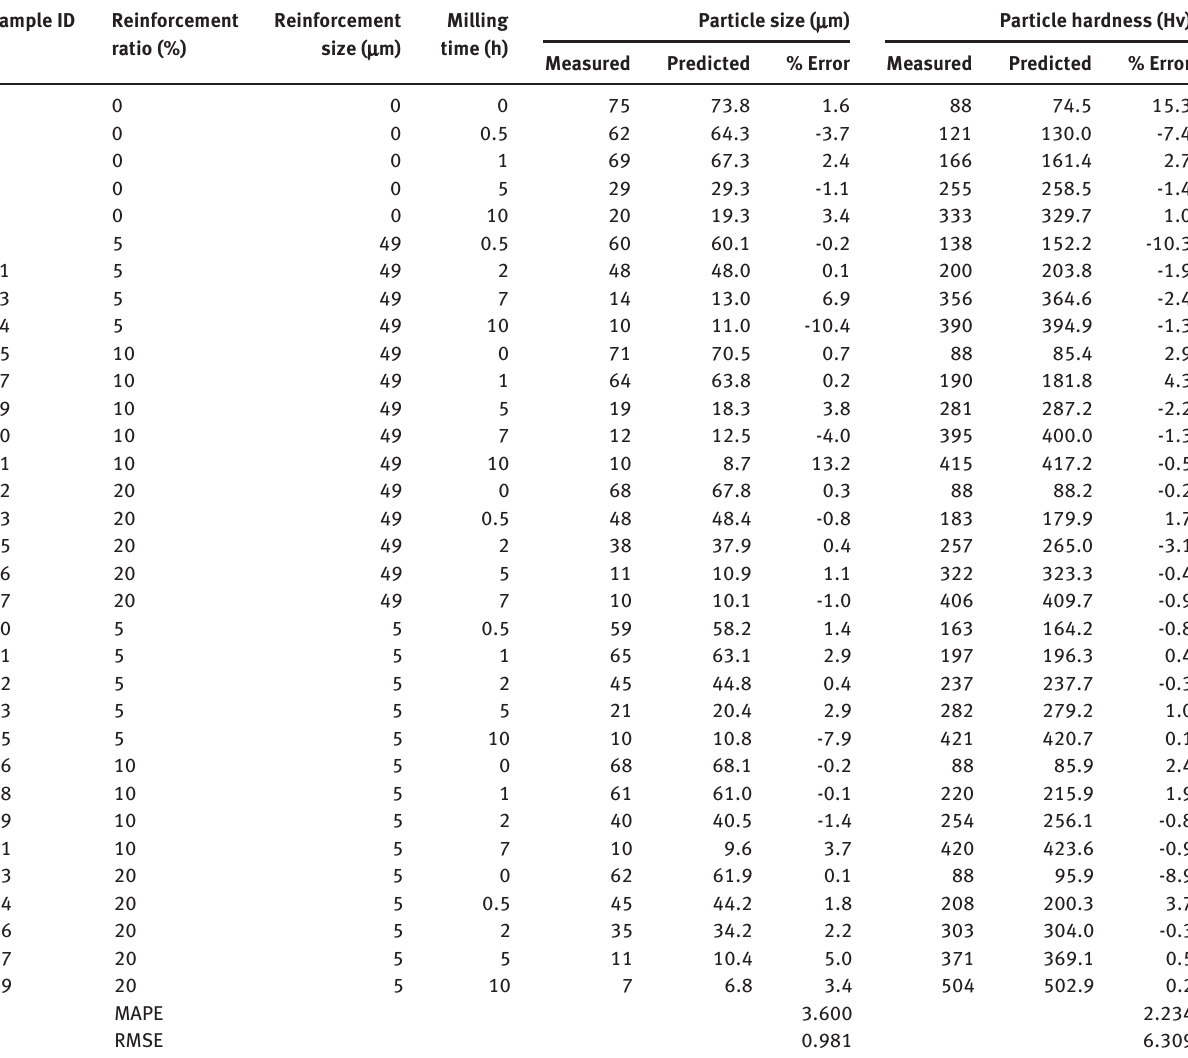
Table 2 Experimental data and predicted output from the ANN network for training set. Sample